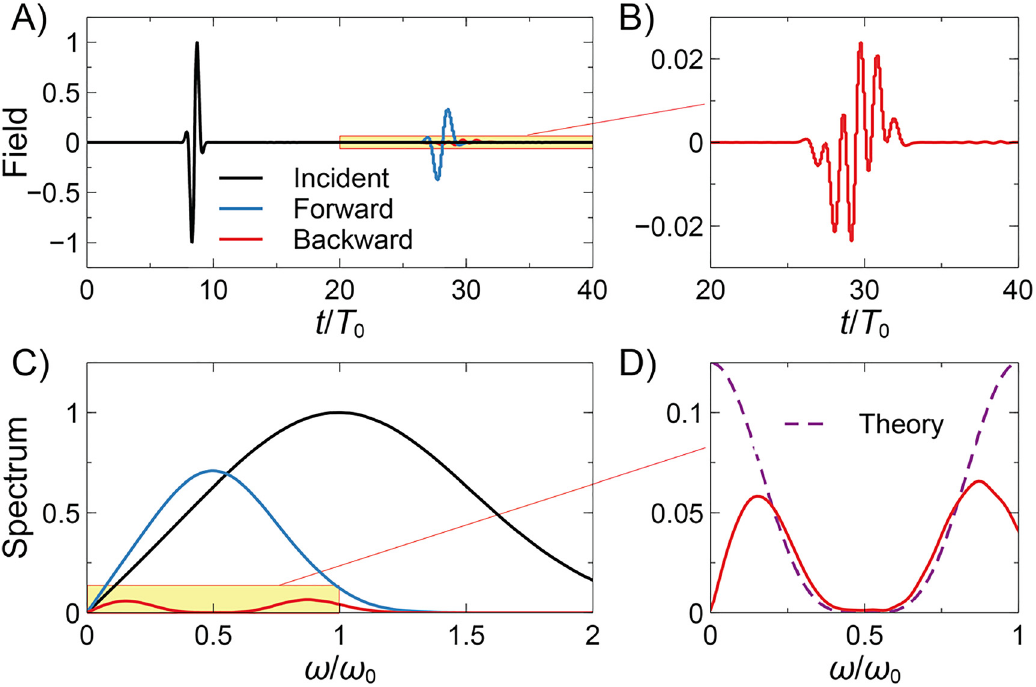
Figure 4: Parameters as in Figure 2 (binomial design), but broadband pulsed excitation. (A) Numerically computed (normalized) incident, FW, and BW waveforms (black, blue, red curves, respectively) at fixed positions ( x = − 6 . 7 λ 0 for the incident and BW waves, and x = 6 . 7 λ 0 for the FW wave). (B)Magni fi ed details of the BW waveform[yellow-shaded area inpanel (A)]. (C) Corresponding (normalized) spectra (magnitude). (D) Magni fi ed details of the BW spectrum [yellow-shaded area in panel (C)], compared with the theoretical prediction (purple-dashed